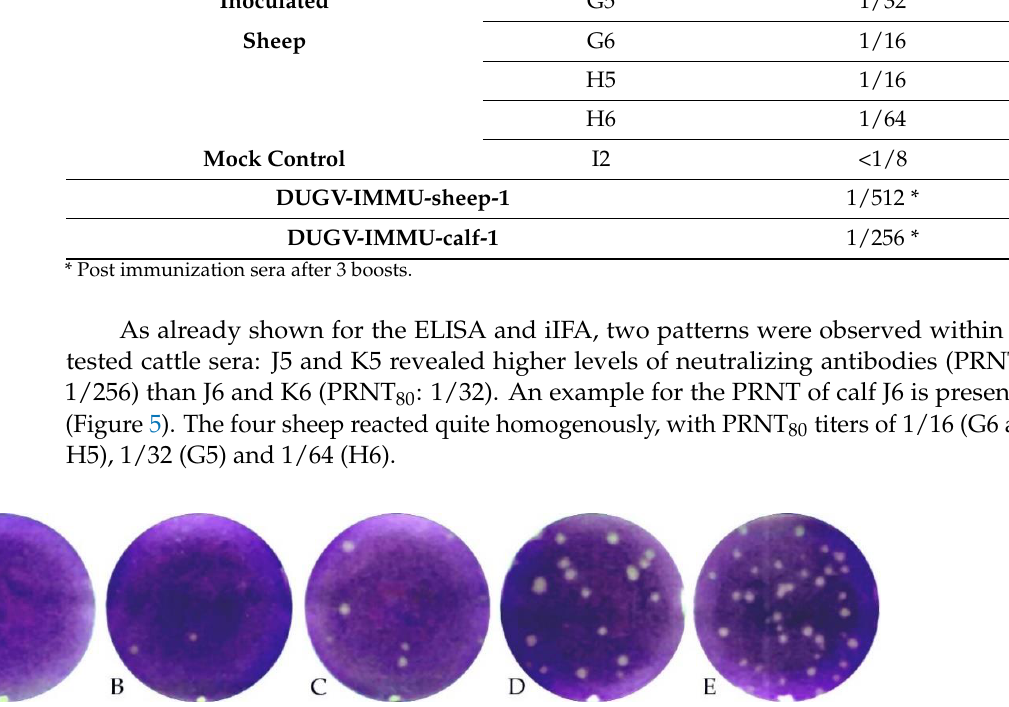
Figure 5. Plaque reduction neutralization test (PRNT) of calf J6 (28 dpi). Serial 1/2 dilutions of the serum from 1/8 ( A ) to 1/128 ( E ) show a steady increase in plaques. Eighty percent of plaques were reduced up to 1/32 ( C ).